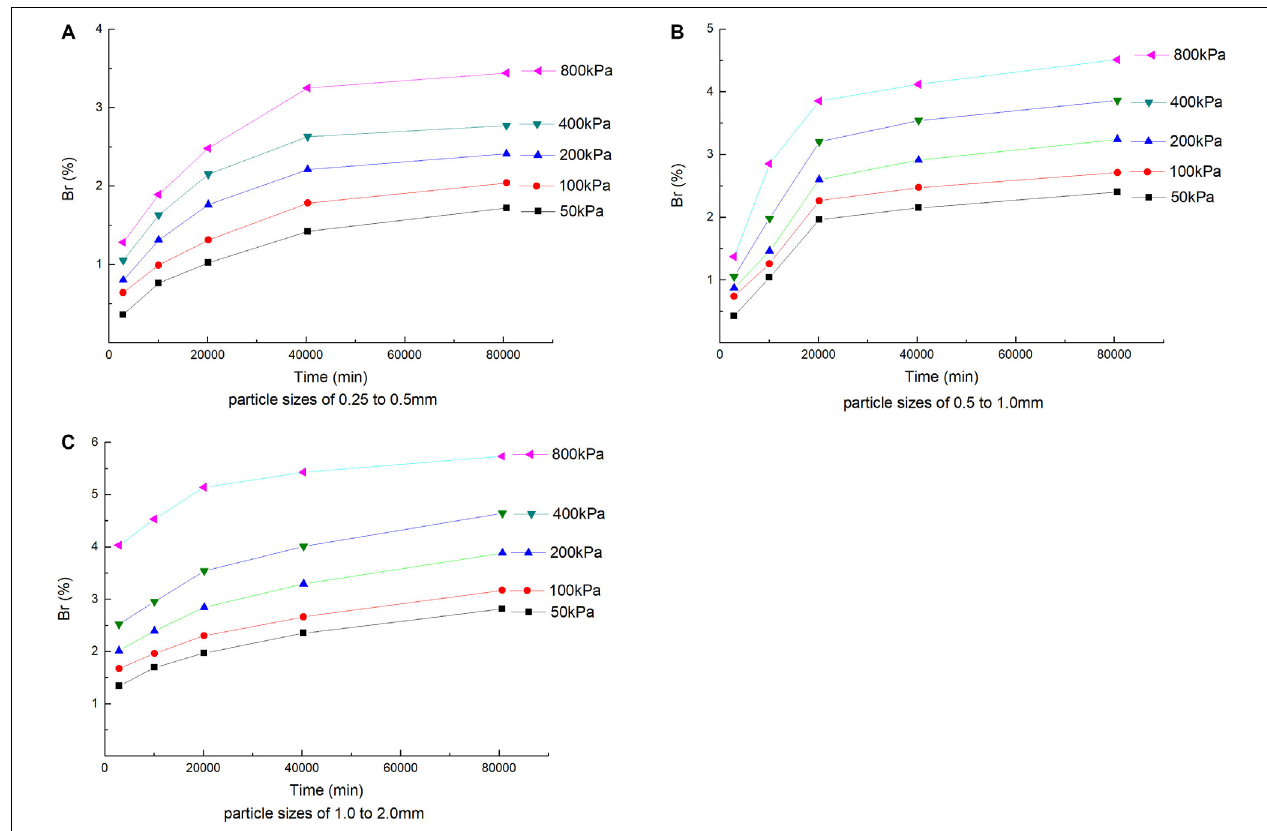
FIGURE 12 | Effect of time on particle breakage. (A) Particle sizes of 0.25–0.5 mm, (B) particle sizes of 0.5–1.0 mm, and (C) particle sizes of 1.0–2.0 mm.